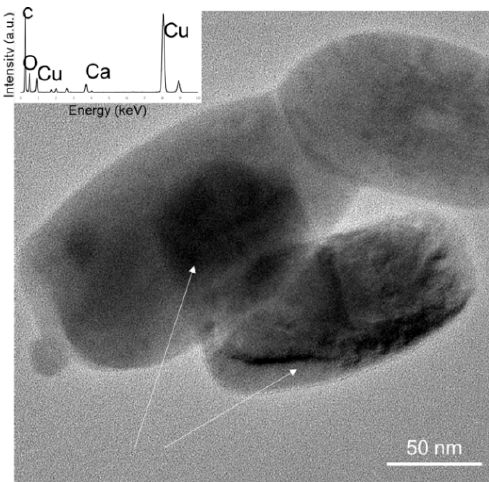
Figure 7. Cu included nanoparticles in HRTEM. Inset energy dispersive X-ray (EDX) profile acquired on the particle.